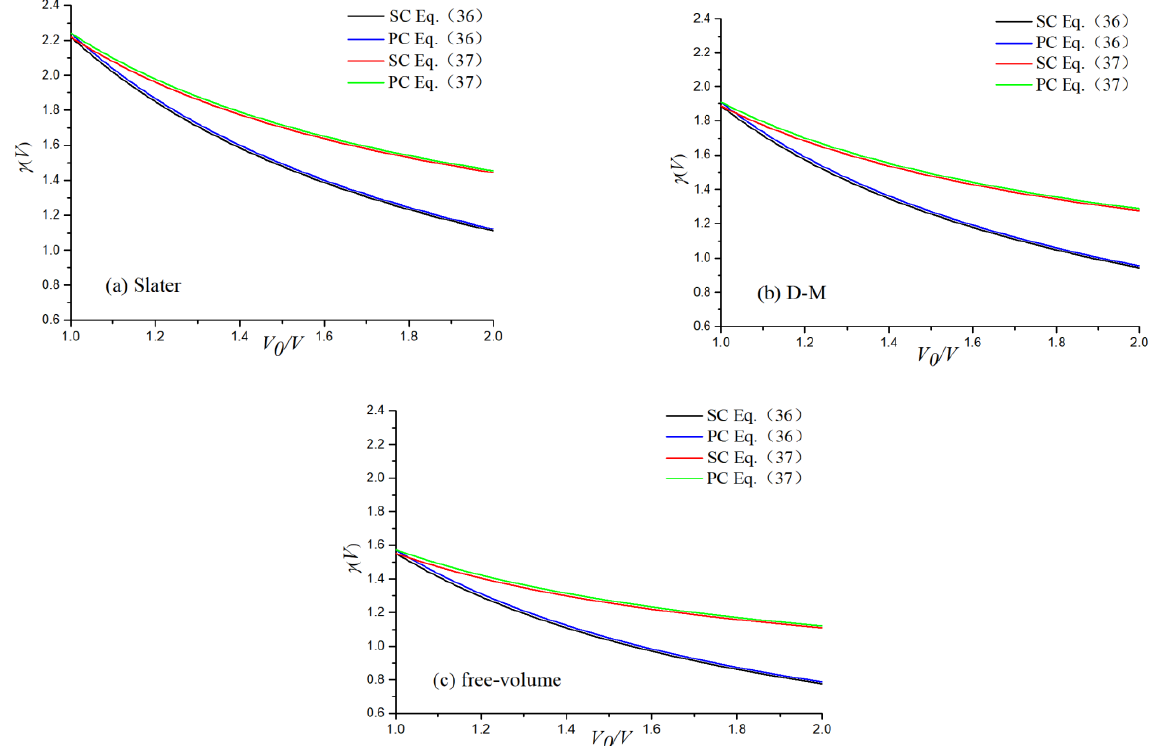
Figure 7. Grüneisen coefficient γ ( V ) based on three models.